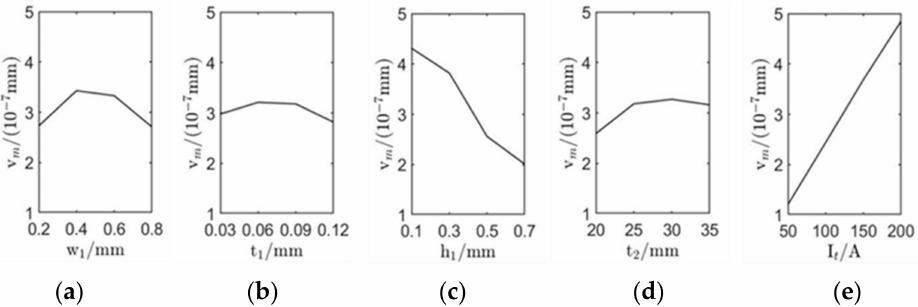
Figure 6. Influence of varying the EMAT design parameters on the amplitude of out-of-plane displacement of surface waves: ( a – e ) successively show the influence of coil width w 1 , coil thickness t 1 , coil lift distance h 1 , permanent magnet thickness t 2 , and excitation current peak value I t on the amplitude of out-of-plane displacement.